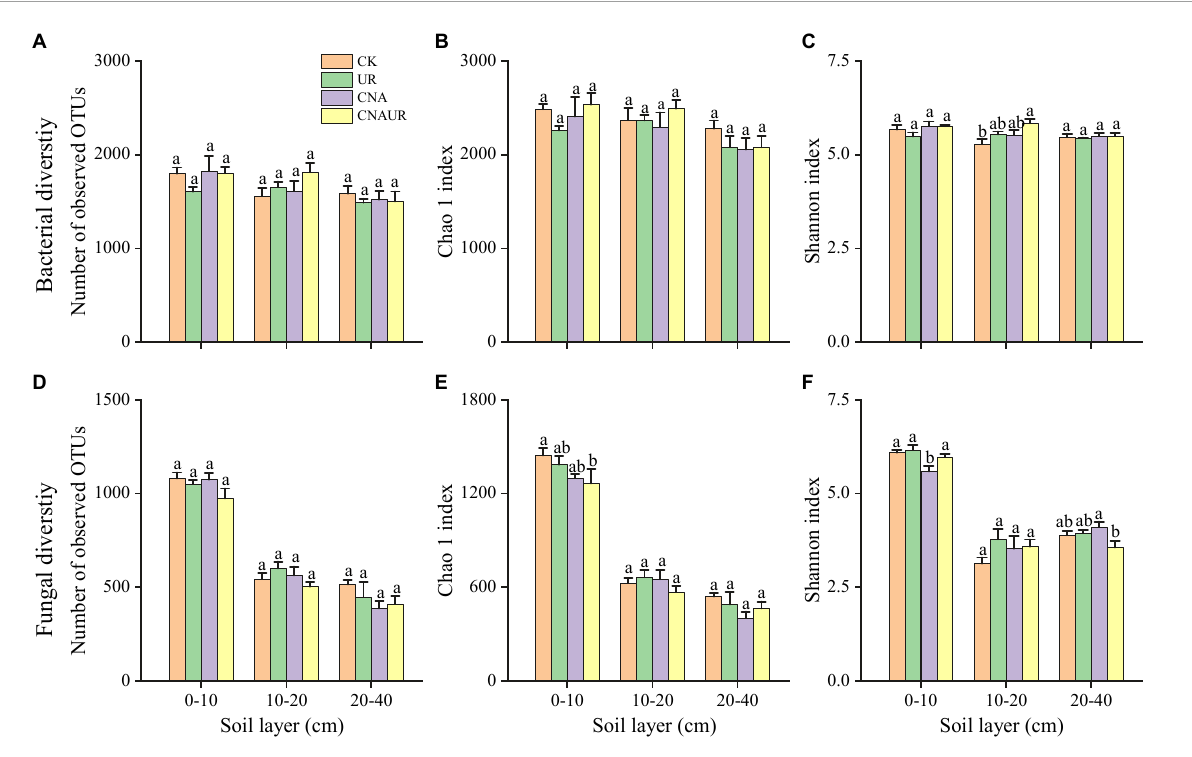
FIGURE3 Diversity indices of bacteria (A–C) and fungi (D–F) in three soil layers as affected by four treatments (treatments are described in Table 1 ). Values are means ± SE. In each plot, means with different letters are significantly different at p < 0.05.